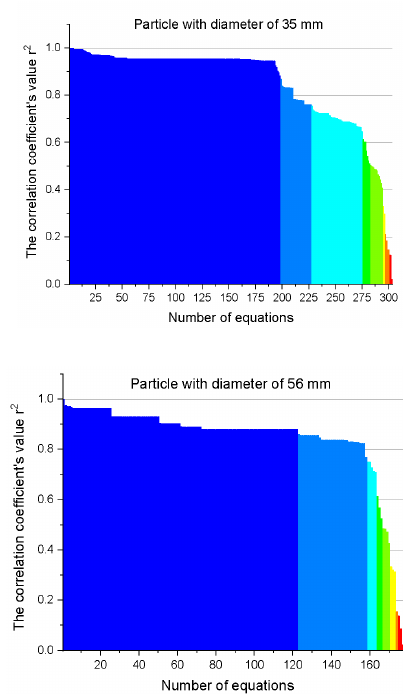
Figure 5. According to the value of the coefficient r 2 for the linear average velocity, the Table Curve 3D program generates a certain number of equations [43].